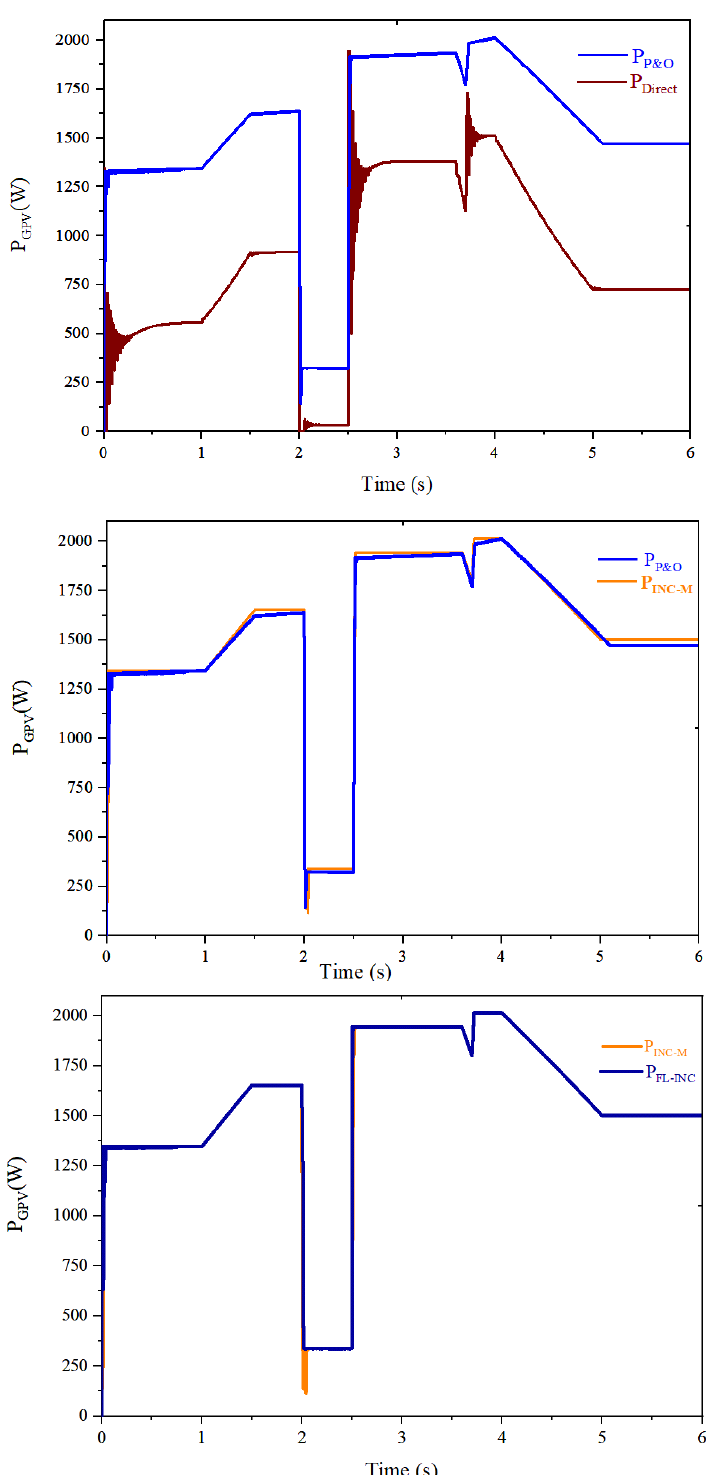
Figure 16. Instantaneous power of different solar water pumping techniques studied.